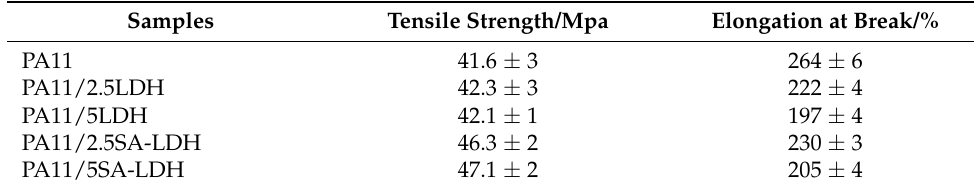
Table 6. Summary of mechanical properties for PA11 and its composites. Samples Tensile Strength/Mpa Elongation at Break/%